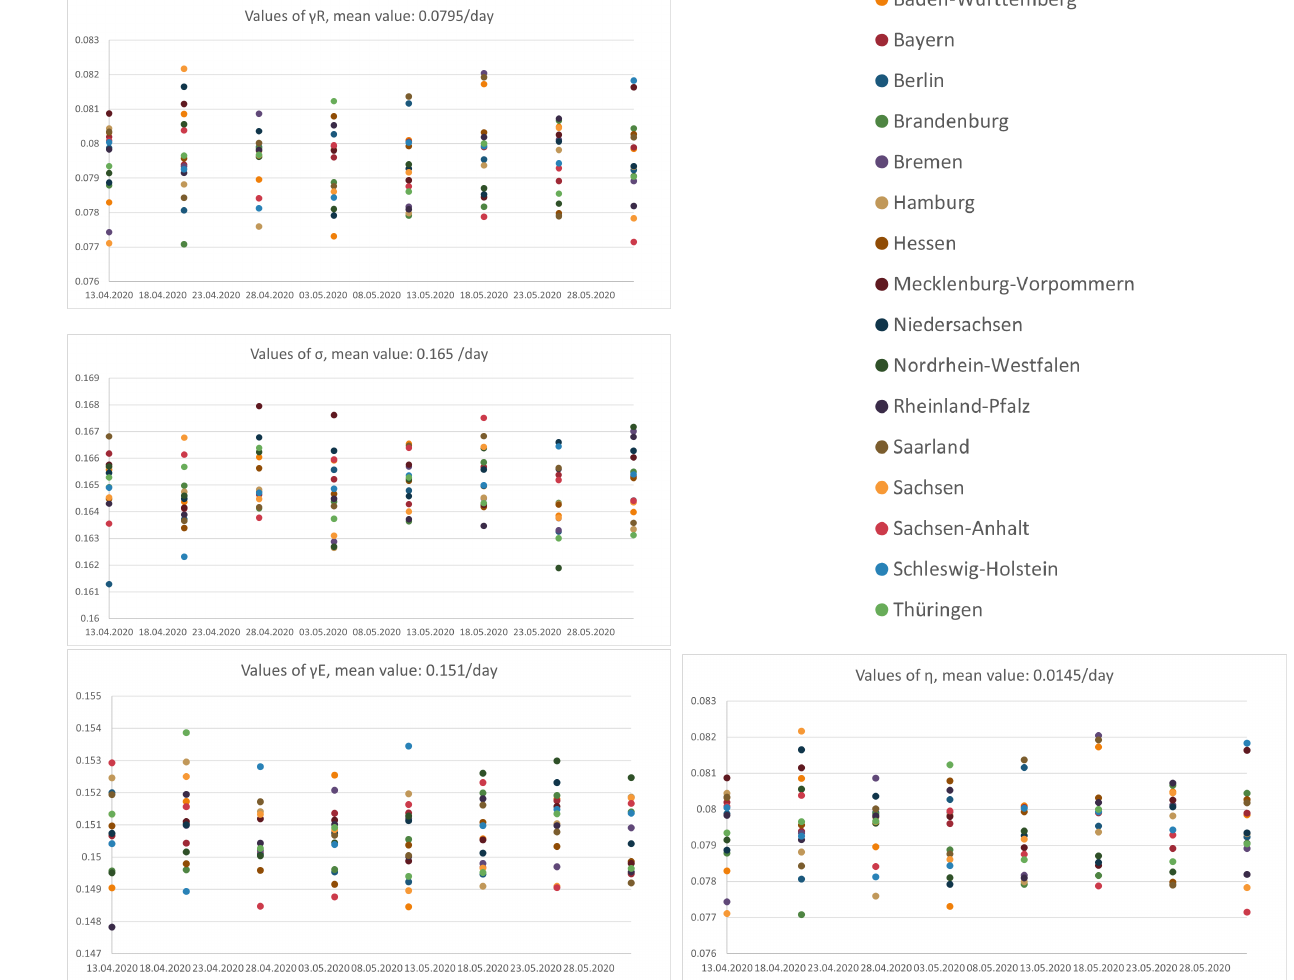
Figure 6. Values of the parameters σ , γ E , R , η with different time period fitting for the respective federal